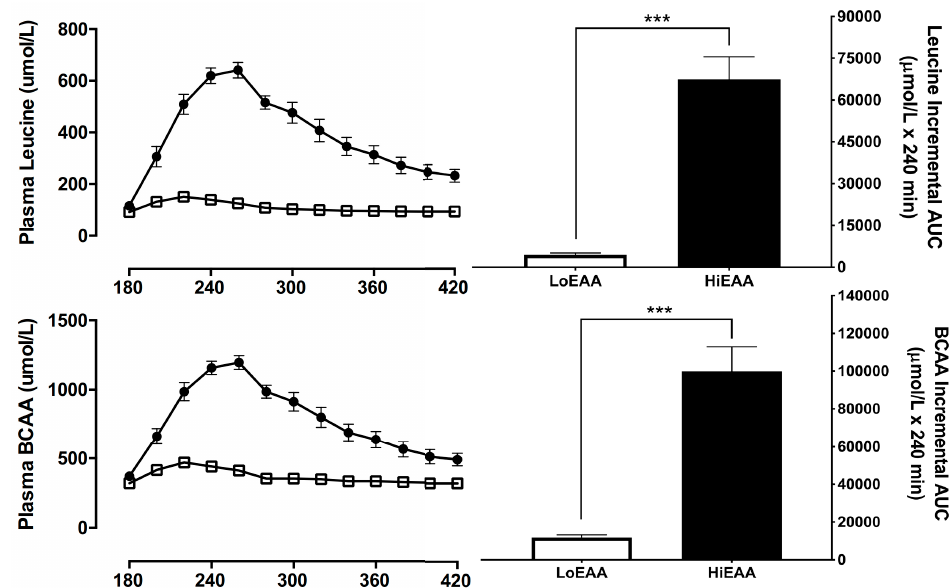
Figure 5. Time course responses and total area under curves (AUC) of plasma concentrations of essential amino acids (EAAs), non-essential amino acids (NEAAs), leucine, and branched chain amino acids (leucine, isoleucine, valine, BCAAs) following either consumption of the HiEAA or the LoEAA. There were significant effects for treatment, time, and treatment-by-time interaction for EAAs, leucine, and BCAAs (for all, p < 0.001) as well as NEAAs (for all, p < 0.02). Values ( n = 8) are expressed as mean ± SEM. *** significantly different from the LoEAA, p < 0.001.